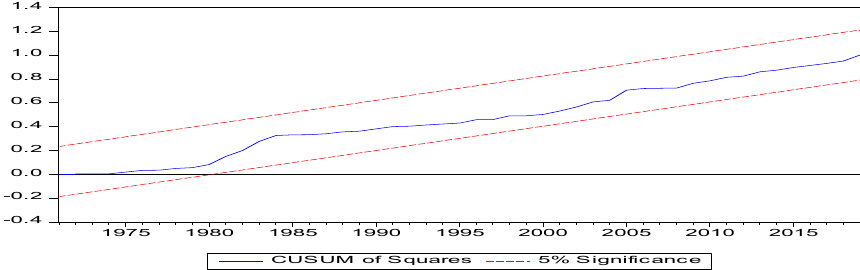
Figure 3. Plot of cumulative sum of recursive residual for Life Expectancy Model.